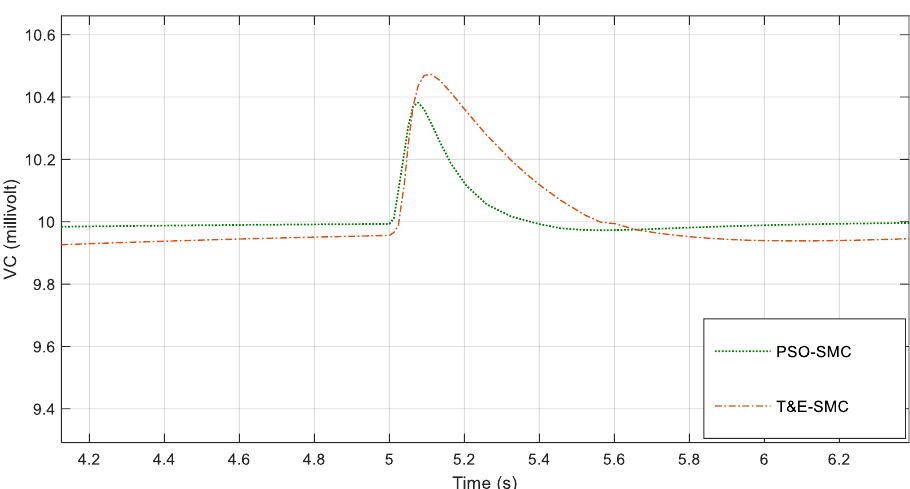
Figure 7. Magnification of Figure 5 around the fifth second.